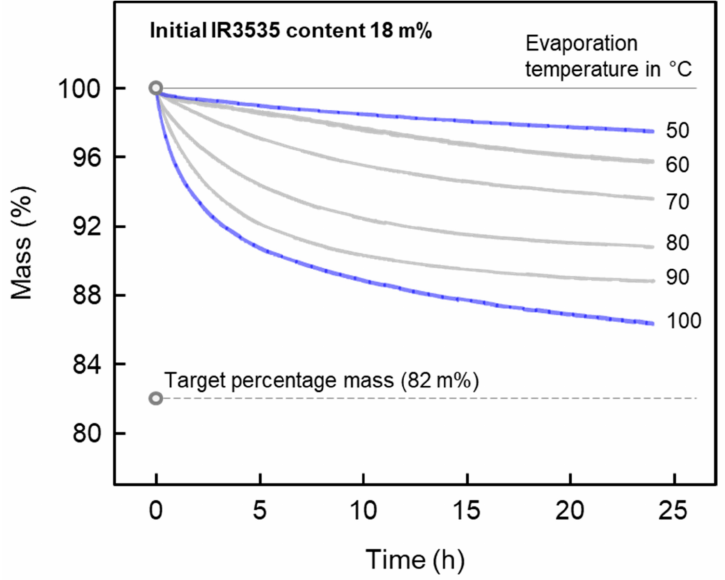
Figure 11. Percentage mass of a PLLA/IR3535 extrudate initially containing 18 m% IR3535 as a function of time during annealing at temperatures between 50 and 100 ◦